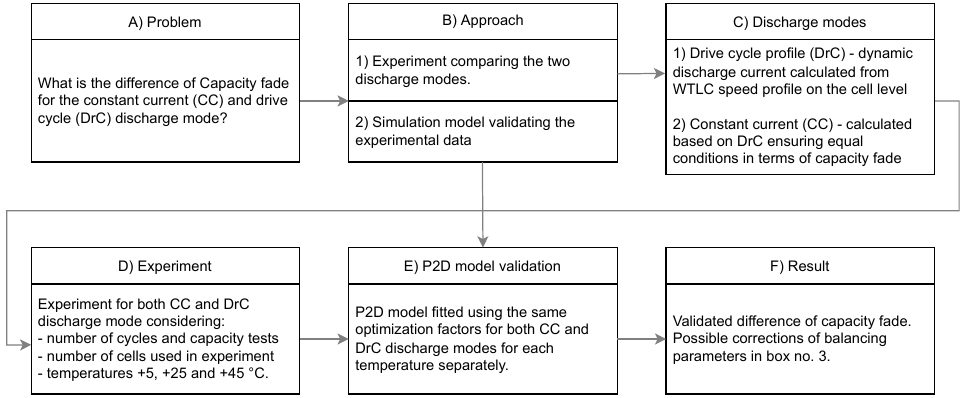
Figure 1. Diagram of comparison method in 6 main steps with the following reference to appropriate section of this paper in parenthesis: ( A ) problem (Section 1.5), ( B ) approach (Section 2), ( C ) discharge modes: drive cycle profile (Section 2.4), balancing parameters of the discharge modes (Section 2.5), ( D ) experiment: cells choice (Section 3.3), conditions (Section 2.1), setup (Section 3) and results (Section 4), ( E ) P2D model validation (Section 5), ( F ) results (Section